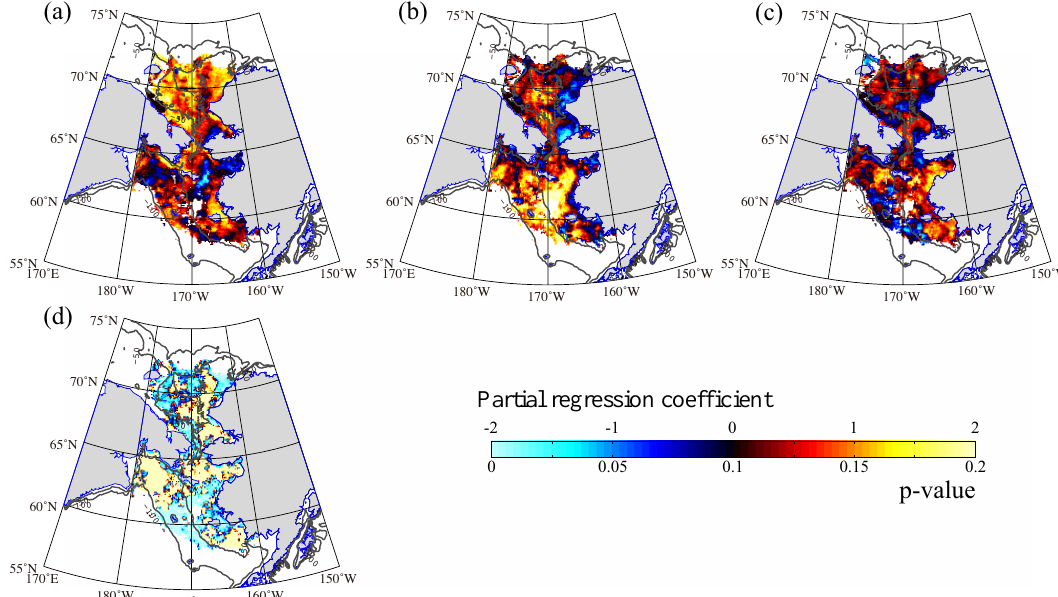
Figure 6. Distributions of the partial regression coefficient from Eq. (7) for (a) standardized length of open-water period, (b) standardized annual median of F L , and (c) standardized annual median of SST. The distribution of the p -value as a result of the F test for Eq. (7) is shown in Fig. 6d. Note that the colour scales in Fig. 6a–c are indicated on the upper tick marks on the colour bar, and the scale in Fig. 6d is indicated on the lower tick marks. Contours indicate 50m and 100m bathymetry